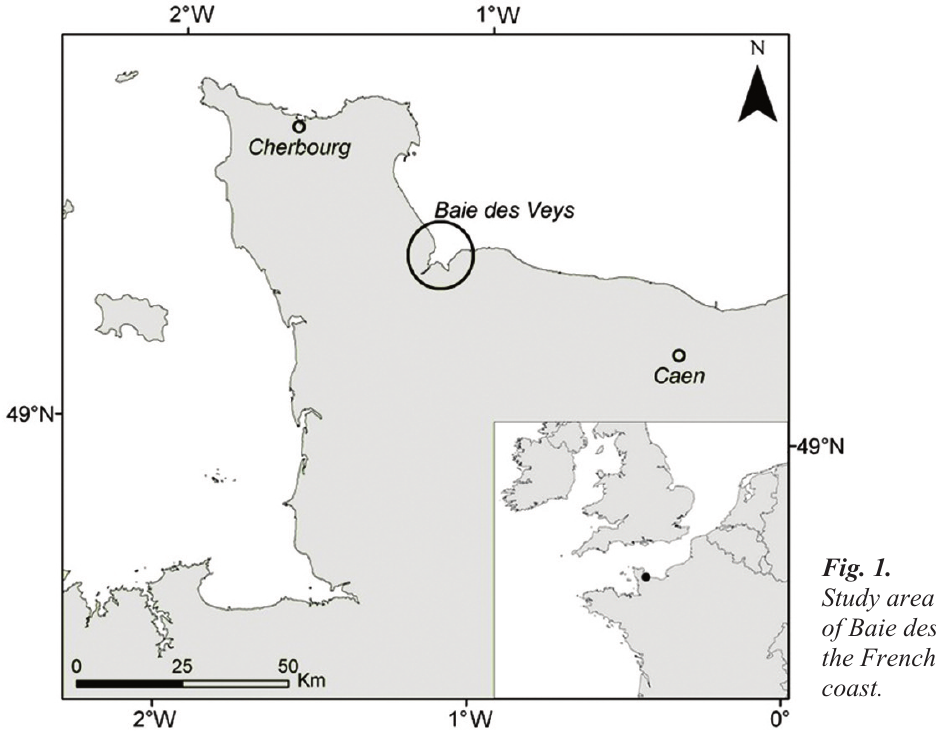
Fig. 1. Study area: location of Baie des Veys on the French Channel